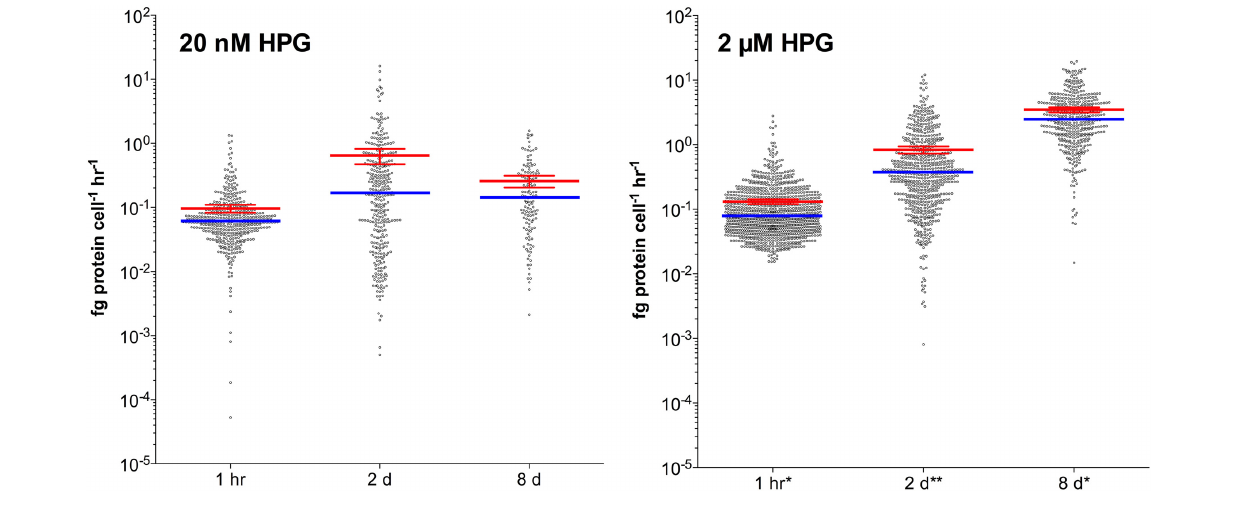
confidence intervals) while blue bars display the medians. Samples denoted ( ∗ ) exhibited 100% labeling and ( ∗∗ ) denotes > 90% labeling of DAPI-stained